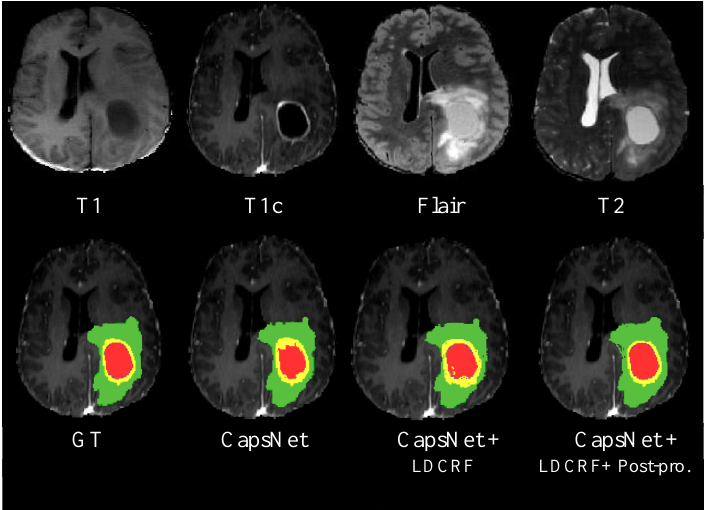
Figure 8. Results of segmentation on MR images with respect to the MICCAI BRATS 2021 dataset. Four input modalities are shown in the top row from left to right (T1, T1c, Flair, T2). Ground truth (GT) as well as segmentation outcomes utilizing CapsNet, CapsNet + LDCRF, and CapsNet + LDCRF + post-processing, respectively, in the bottom row (left to right) with red label 1 (necrosis), green label 2 (edema), blue label 3 (non-enhancing), and yellow label 4